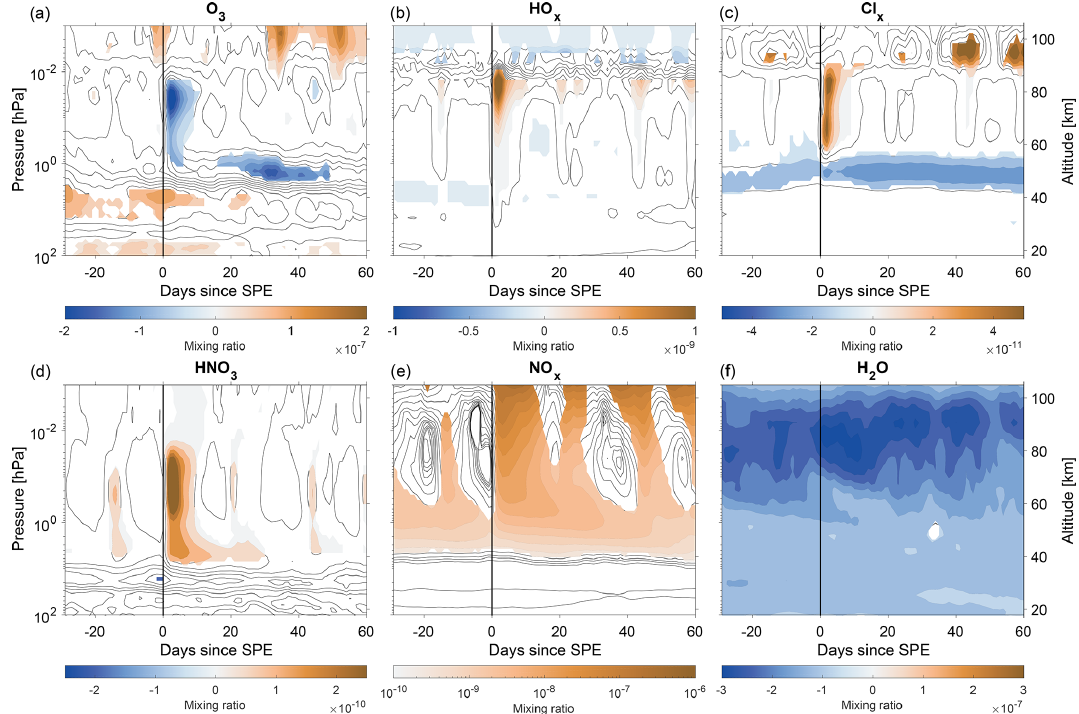
Figure 4. Area-weighted northern polar cap averages (latitude > 60 ◦ N) of composite means of (cid:100) WD for O 3 , HO x , Cl x , HNO 3 , NO x and H 2 O. The x axis shows the number of days before and after the event (day 0, solid black line) and the y axis pressure levels in the model (hPa, a, d ) and approximate altitude (km, c, f ). Note that the color scale for NO x panel is logarithmic, and all contours shown in that panel indicate positive